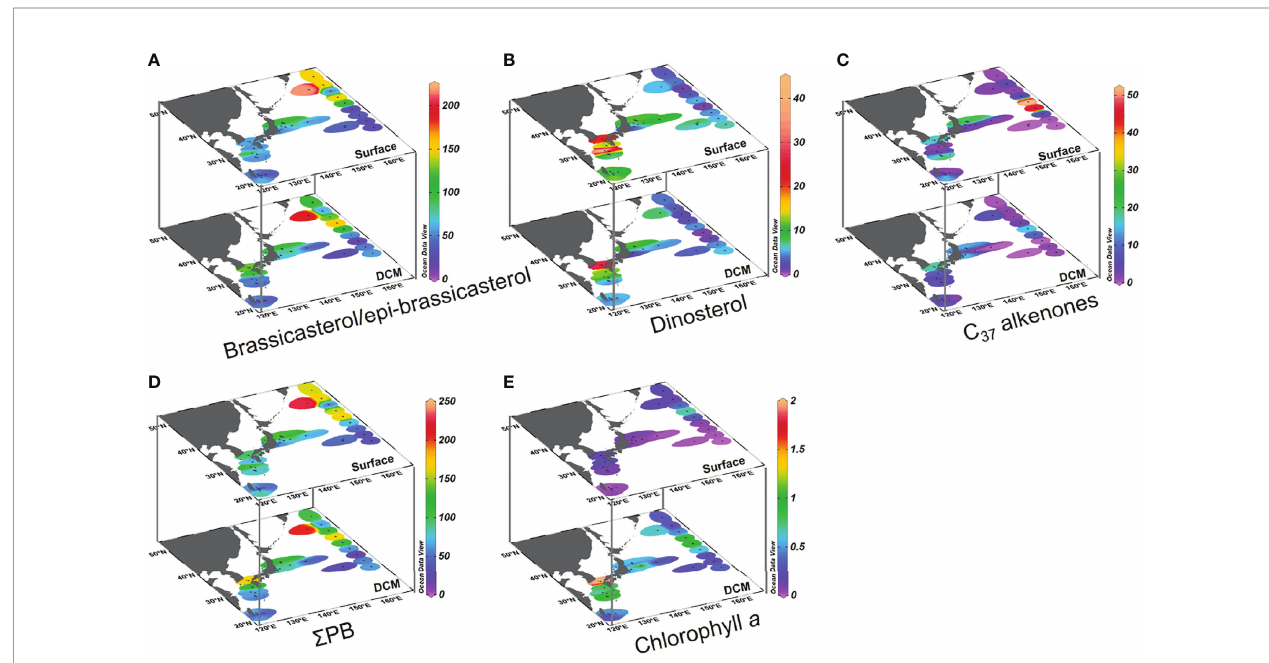
FIGURE 3 | Distributions of lipid biomarkers and chlorophyll a in surface and DCM waters of the Northwest Paci fi c Ocean in summer: (A) brassicasterol/epi- brassicasterol (ng L − 1ng L − 1 ), (B) dinosterol (ng L − 1 ), (C) C37 alkenones (ng L − 1 ), (D) the sum of brassicasterol/epi-brassicasterol, dinosterol, and C37 alkenones ( S PB; ng L − 1 ), and (E) chlorophyll a ( m g L − 1 ). Note the difference in color